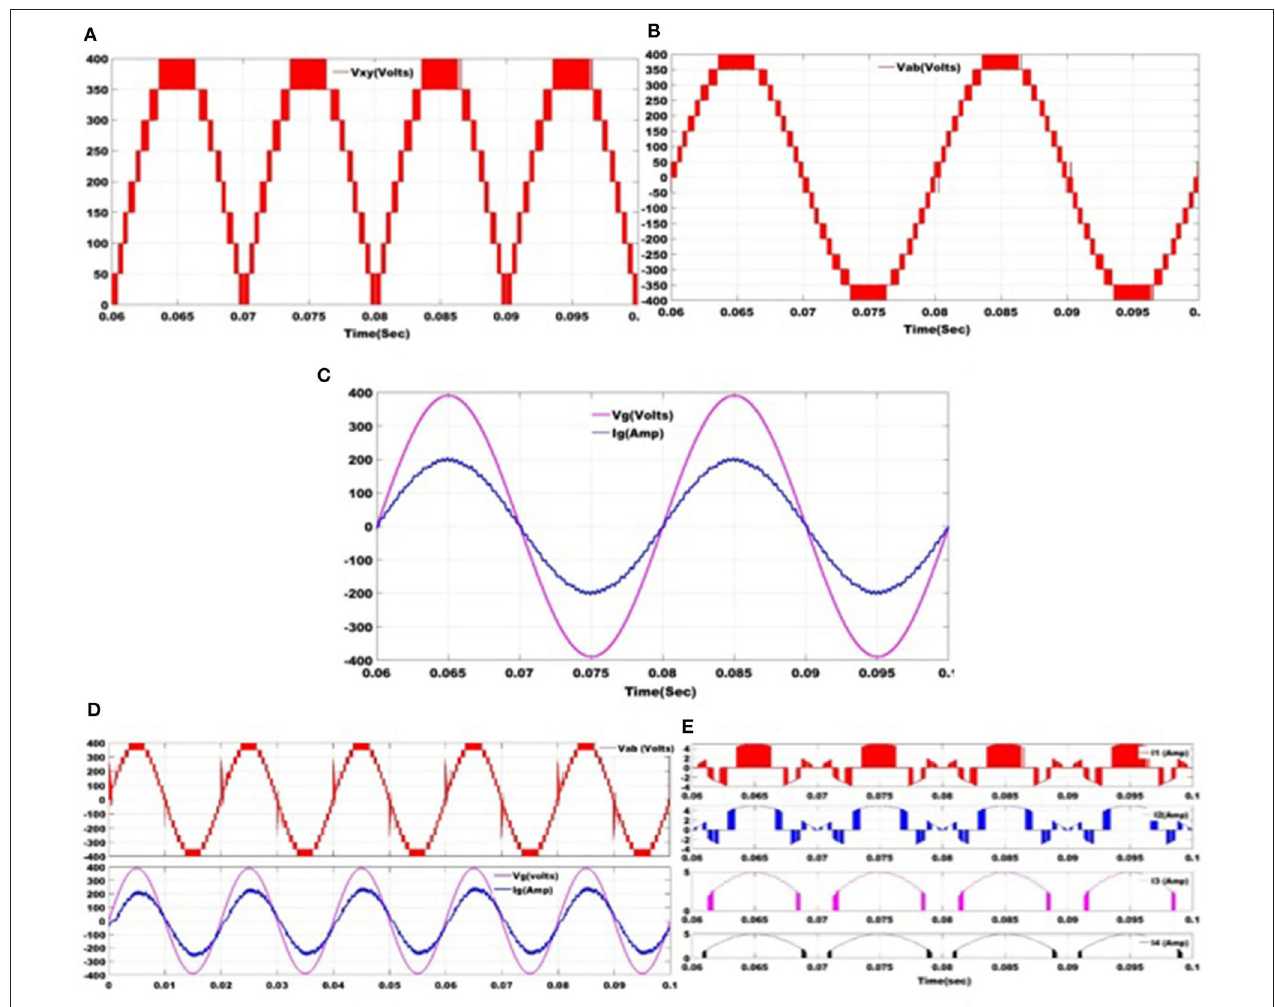
FIGURE 9 | The simulated waveforms of the grid connected seventeen level inverter topology; (A) output voltage of the level generation circuit (V XY ); (B) output voltage (V ab ); (C) voltage across the grid and current through the grid (Grid current is scaled up 70 times to fit into the graph); (D) output voltage (V ab ), voltage across the grid and current through the grid for non UPF (Grid current is scaled up 70 times to fit into the graph); (E) current through input DC sources I 1 , I 2 , I 3 , and I 4 (Input currents are scaled up two times to fit into the